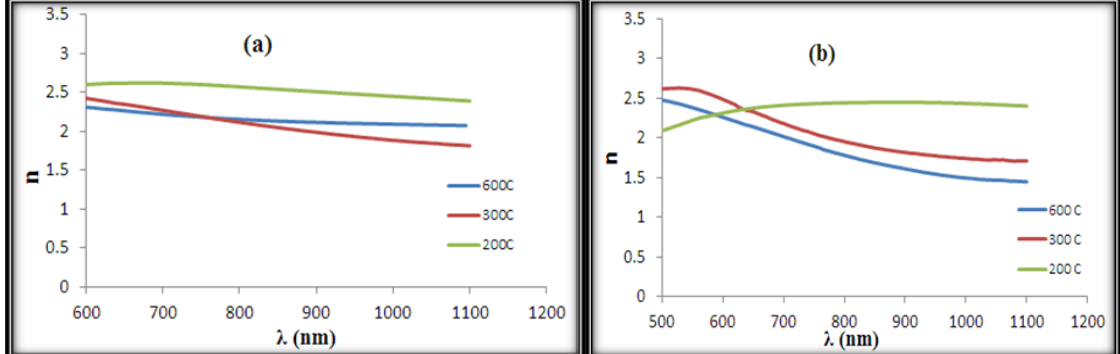
Fig.13: The variation of refractive index (n) with wavelength (λ) of Ag sintered at different temperature (a) as deposited (b) annealed at 200°C for half an